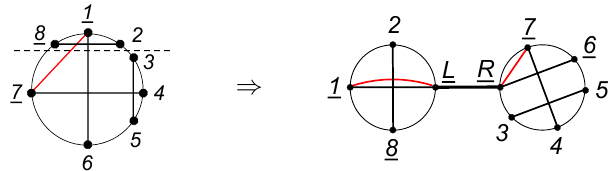
Figure 13 . Non-ladder diagram, A ( I 8 : 16 , 28 , 35 , 47) , and its factorization contribution.